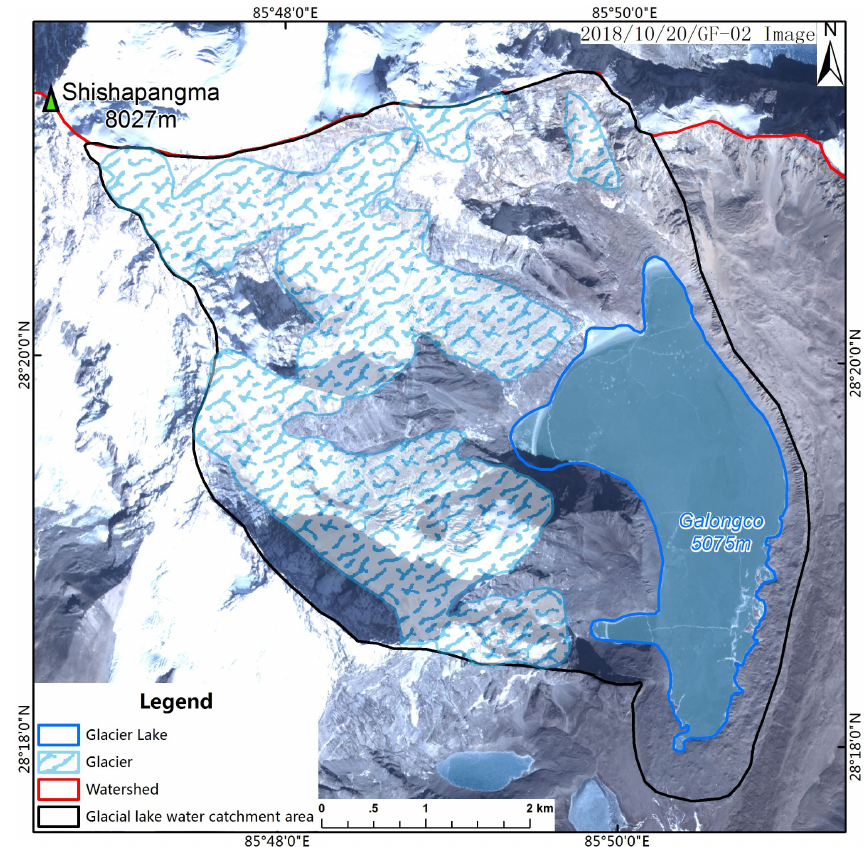
Figure 15. The Galongco Lake and the connected glaciers in 2006. (The image is from the GF-02 images.)